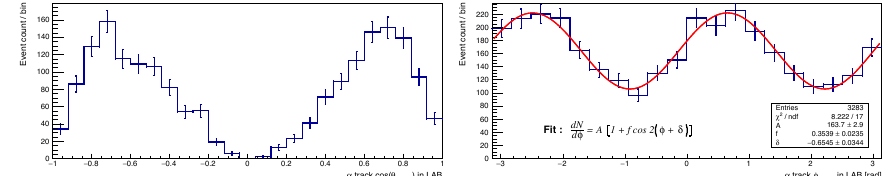
Figure 3. Polar ( θ ) and azimuthal ( φ ) angle distributions (left and right panels, respectively) in the laboratory reference frame for 16 O( γ , α ) events at E γ = 11.5 MeV. Partial statistics. See